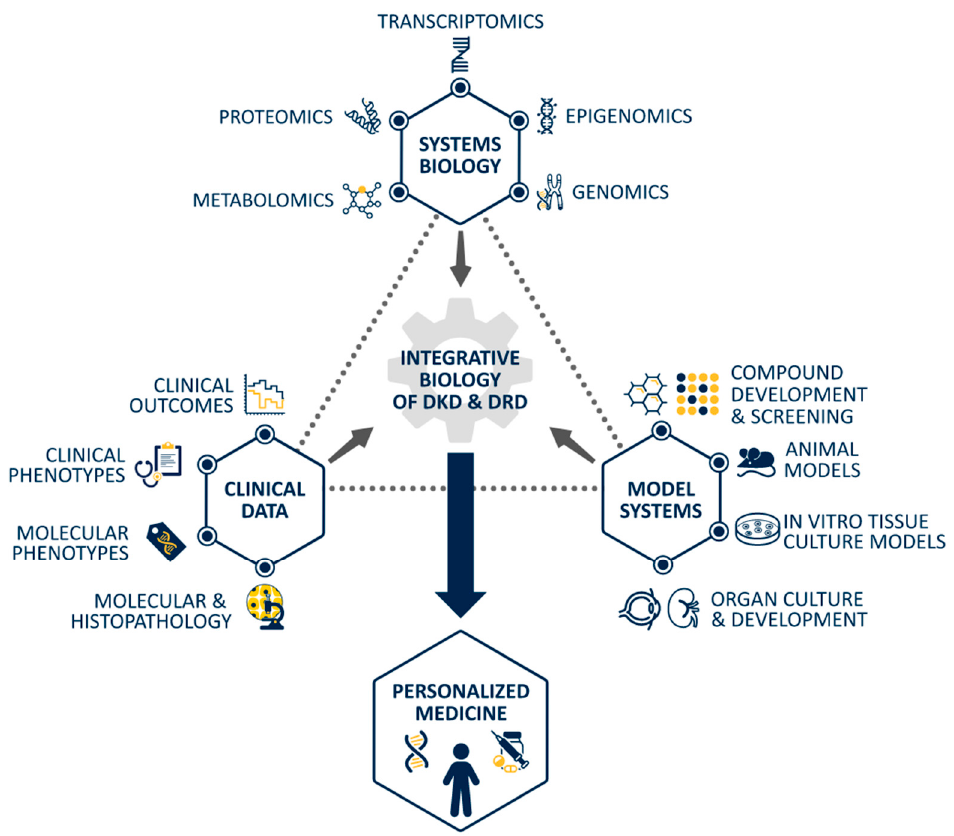
Figure 3. Integrative biology towards personalized medicine. Three main domains of research are depicted and include clinical data, model systems, and systems biology. Within each domain, multiple nodes of scientific research are detailed. For example, the systems biology domain includes genomics, epigenomics, transcriptomics, proteomics, and metabolomics research. The combination of these three domains contributes to integrative knowledge of pathomechanisms of disease, which when applied to both DKD and DRD culminates in personalized medicine.